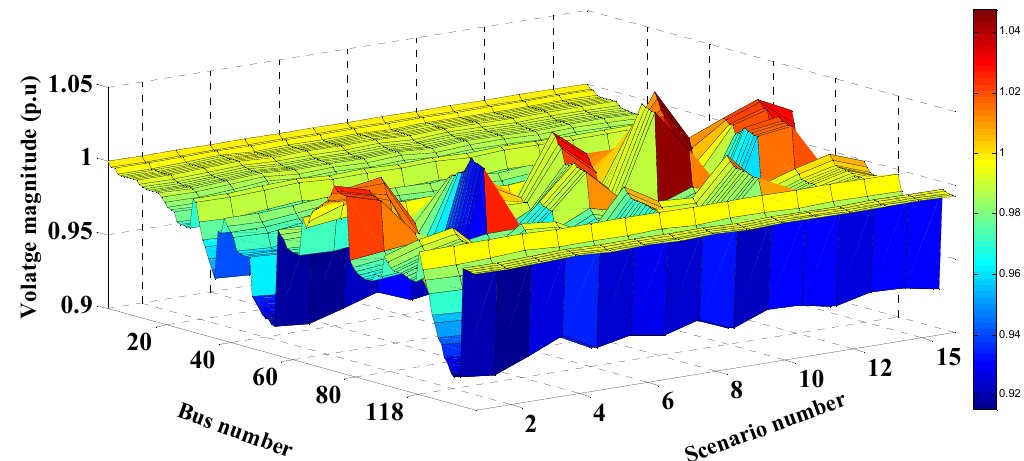
Figure 13. Bus voltage magnitudes of the IEEE 118-bus system with RERs.